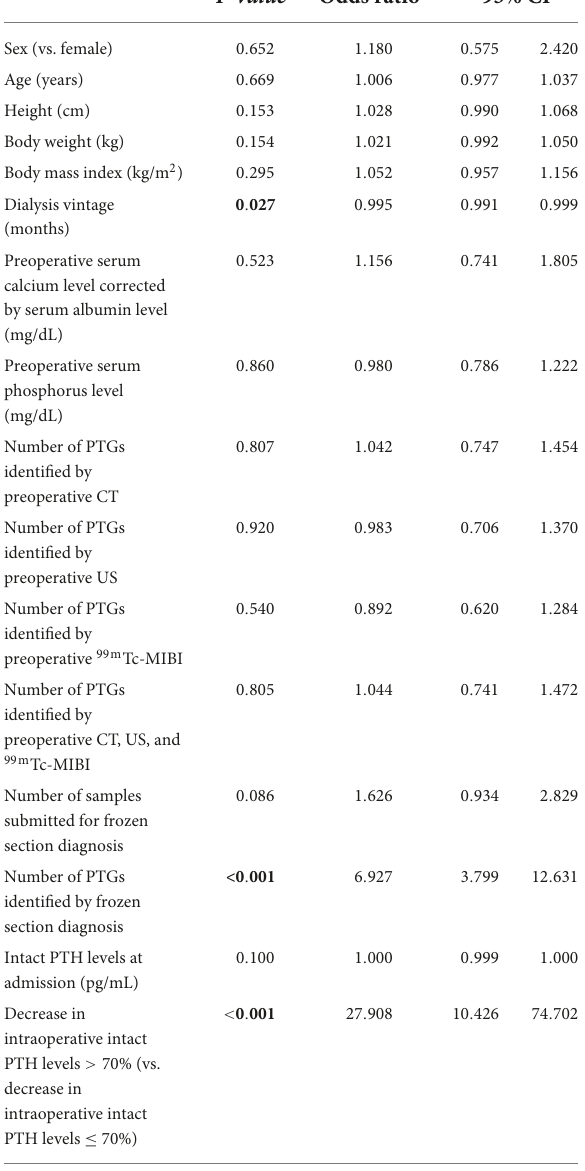
TABLE 4 Univariate logistic regression analysis for successful parathyroidectomy.